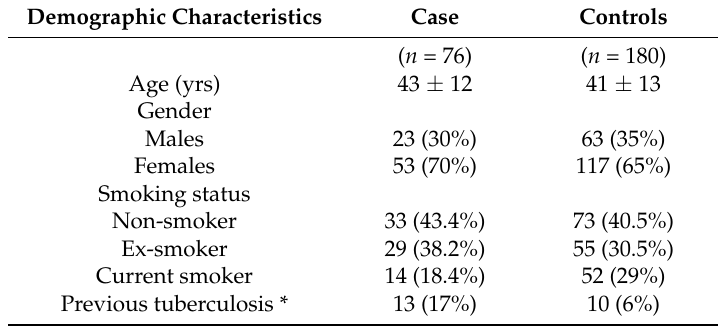
Table 1. Demographic characteristics of study population exposed to the sulphur stockpile fire